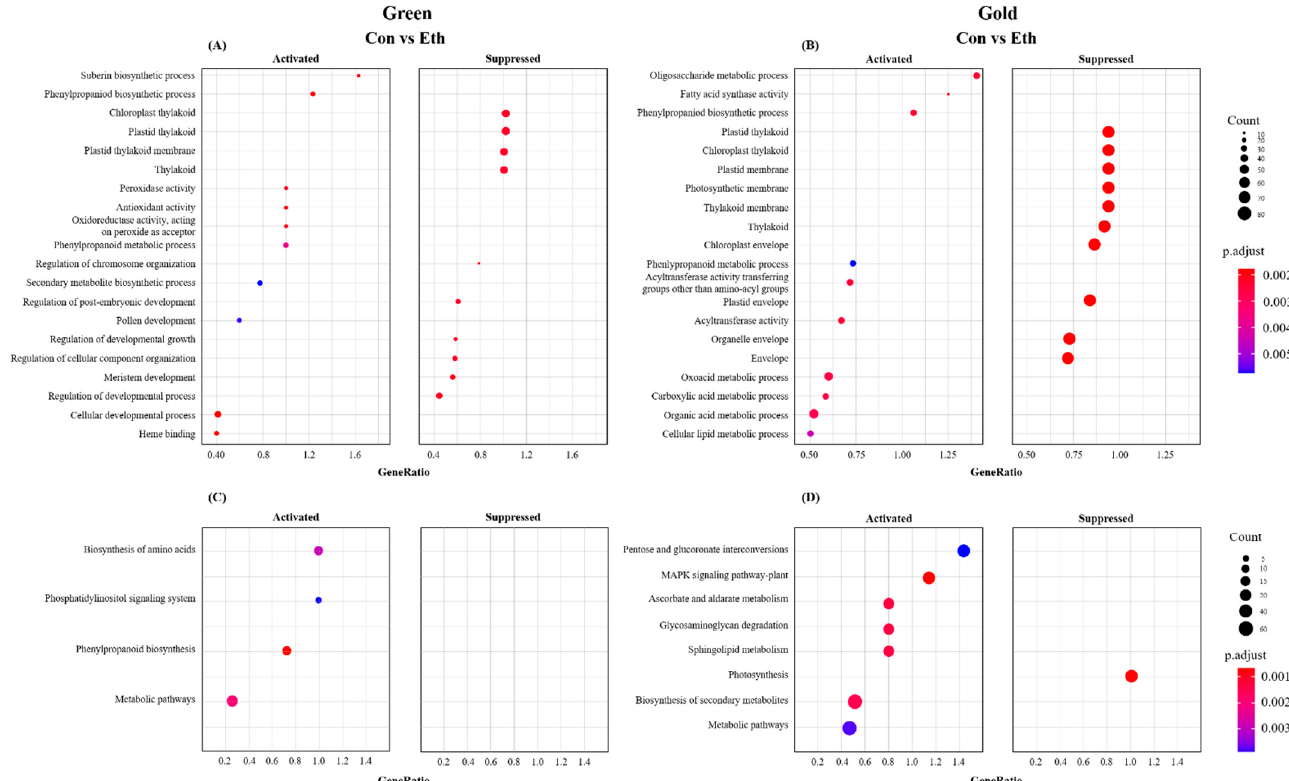
Figure 3. ( A , C ) Go enrichment analysis of the differentially expressed genes in green ‘Hayward’ and gold ‘Haegeum’ kiwifruit cultivars. The horizontal axis represents the gene ratio corresponding to the pathway, and the vertical axis represents the pathway name. p -adjust values are represented by the color of the points. The gene count in each pathway is indicated by size of point and ( B , D ) KEGG pathway enrichment scatter analysis of the differentially expressed genes. The horizontal axis represents the gene ratio corresponding to the pathway, and the vertical axis represents the pathway name. p -adjust values are represented by the color of the points. The gene count in each pathway is indicated by size of point.